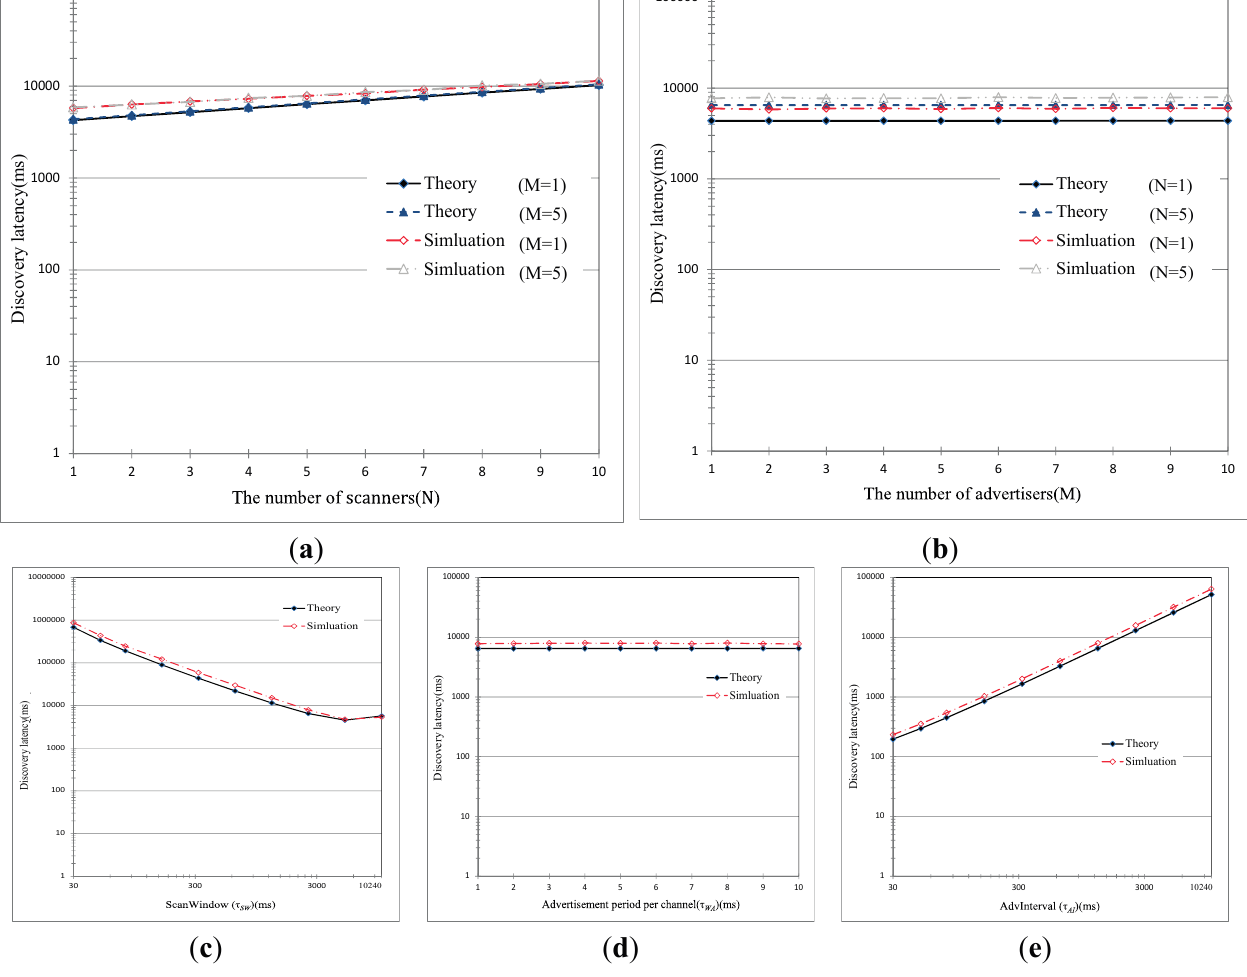
Figure 9. Mean discovery latency with various parameter settings. ( a ) The mean discovery latency as the number of scanners is increased ( τ SI = 10,240, τ SW = 2560, τ WA = 10, τ AI = 1,280); ( b ) the mean discovery latency as the number of advertisers increase ( τ SI = 10,240, τ SW = 2560, τ WA = 10, τ AI = 1280); ( c ) the mean discovery latency as ScanWindow ( τ SW ) is varied ( τ SI = 10,240, τ WA = 10, τ AI = 1280, M = 5, N = 5); ( d ) the mean discovery latency as τ WA is varied ( τ SI = 10,240, τ SW = 2560, τ AI = 1280, M = 5, N = 5); ( e ) the mean discovery latency as AdvInterval ( τ AI ) is varied ( τ SI = 10,240, τ SW = 2560, τ WA = 10, M = 5, N =